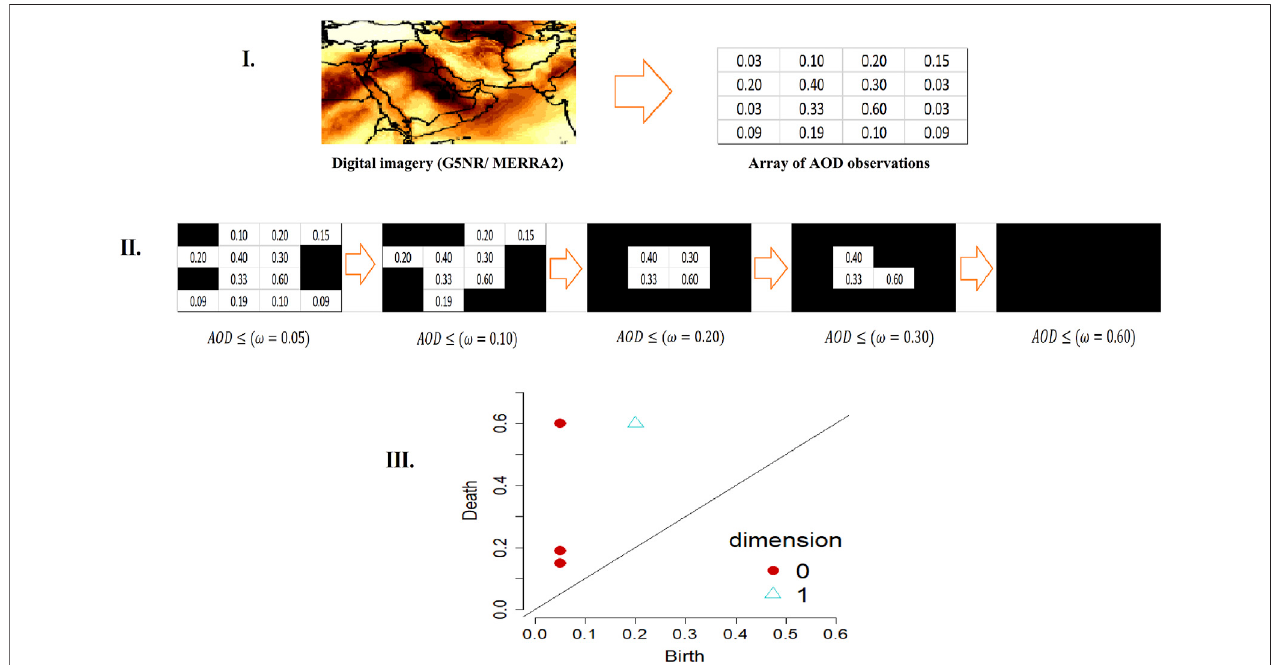
FIGURE2| Illustrationofcubicalcomplex fi ltrationwithitsrespectivesummaryoftopologicalfeatures. (I) AmapofAODobservations,whichcanalsobeviewedas a two-dimensional array. (II) Filtration of cubical complexes from the array of AOD observations. Shaded regions constitute two-dimensional elementary cubes (i.e., squares) formed as the similarity scale changes. (III) Persistence diagram re fl ecting the lifespan of connected components (0-dimensional objects) and holes (1-dimensional objects) seen in II.